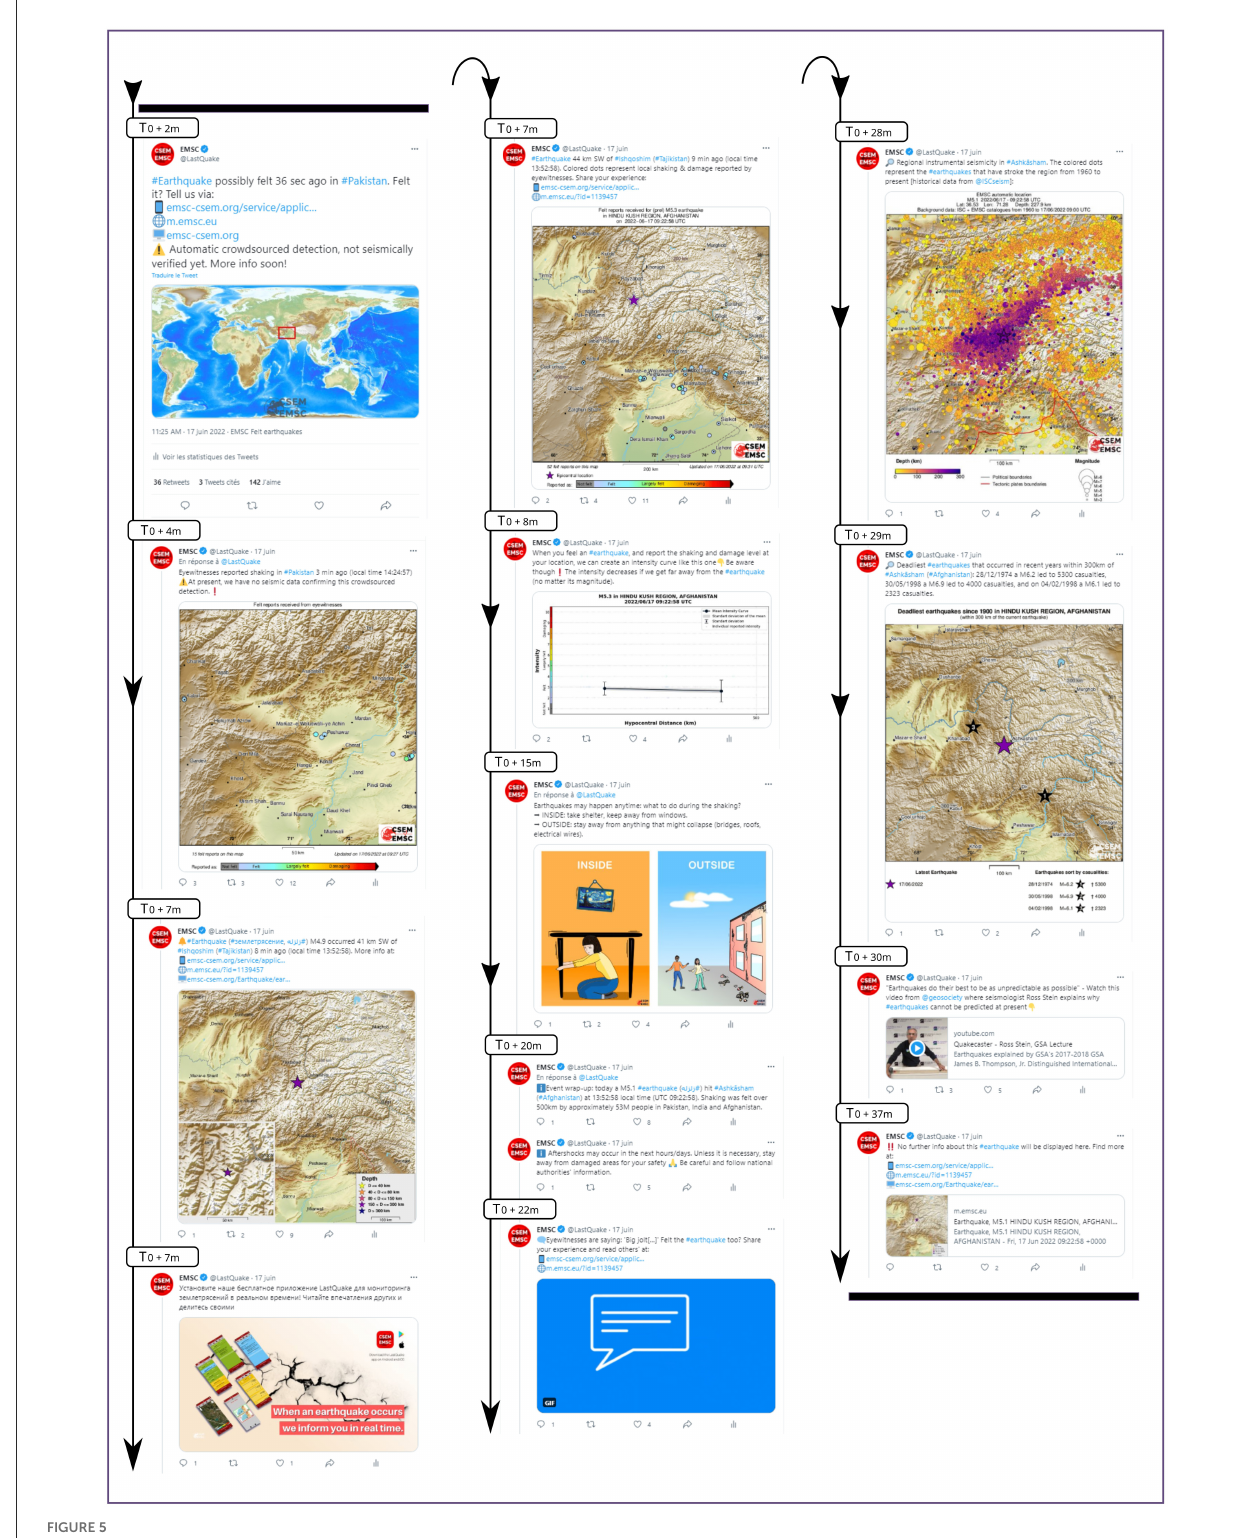
FIGURE5 A thread of tweets automatically published in relation to the destructive M5.9 earthquake on 21 June 2022. Since the damage was not automatically detected, this event was placed in the category “large, with audience” (Figure 4). The publication time for each tweet is indicated with respect to the origin